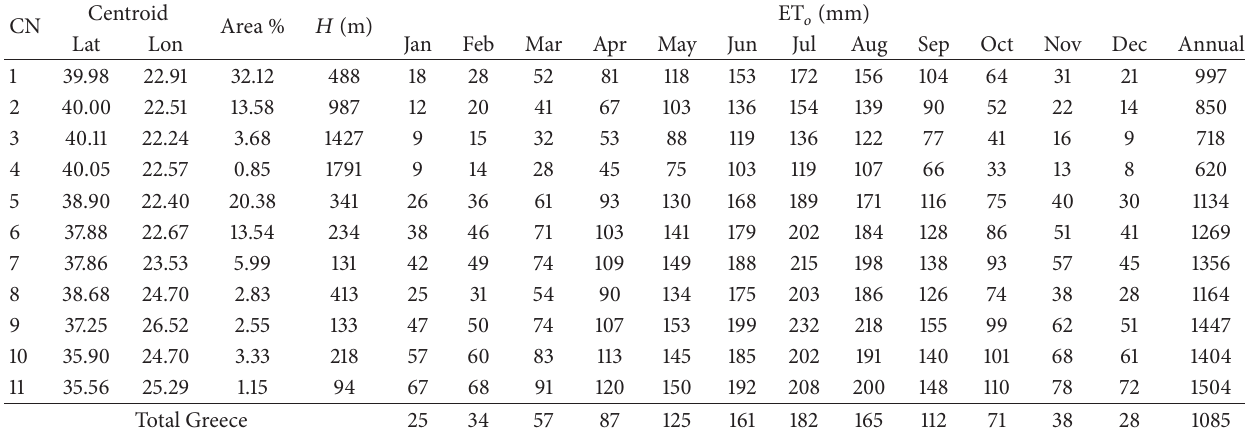
Table 3: Cluster centroids, percent area (%), mean 𝐻 , mean monthly, and annual ET 𝑜 .